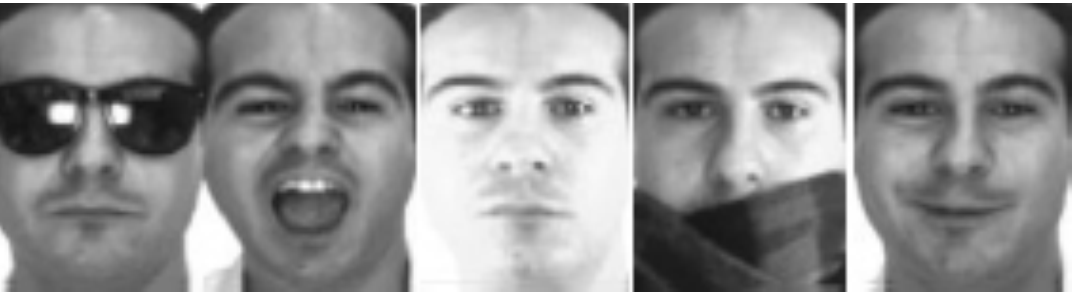
Figure 19. Sample images from the AR face image database.